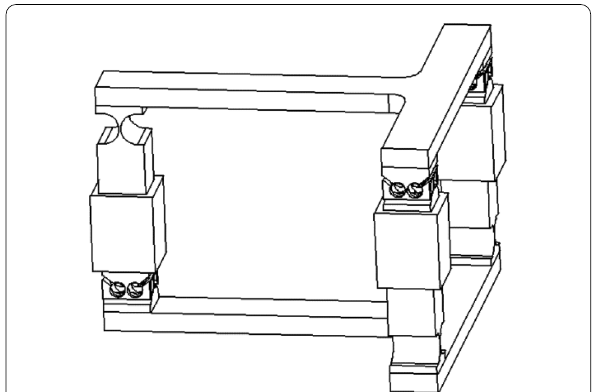
Figure 9 RPR compliant mechanism for FEA simulation